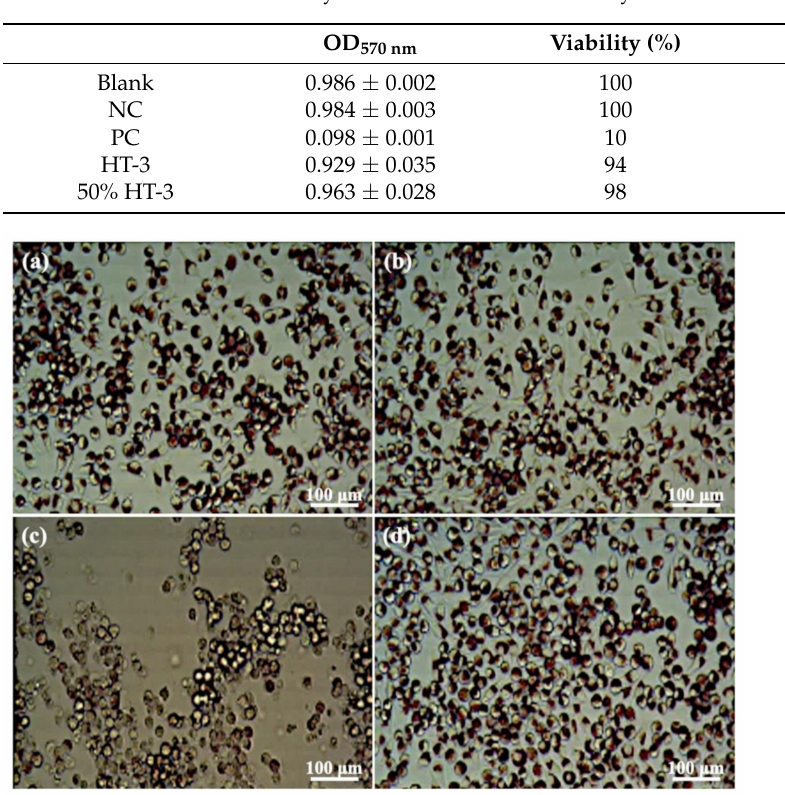
Table 2. The results of MTT assay for evaluation of cell viability.